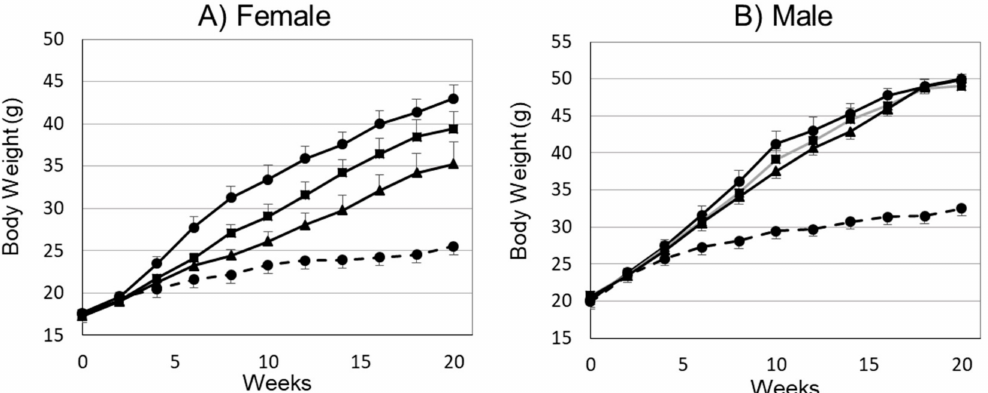
Figure 1. Average body weight of female ( A ) and male ( B ) mice. Normal diet (ND): dotted line; HFD: closed circles; HFD+ miso (M): closed squares; HFD+ pre-fermented miso (PFM): closed triangles. Error bars indicate the standard error of mean (SEM) ( n = 5 or 6). Table 2. Body weight gain and body composition between groups. Female